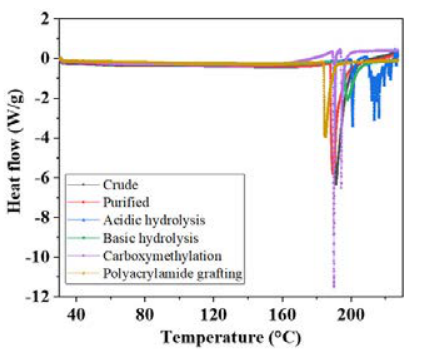
Fig. 3. Fourier transform infrared spectra of crude (a) purified (b) acidic hydrolysis (c) basic hydrolysis (d) polyacrylamide grafting (e) carboxymethylation (f)